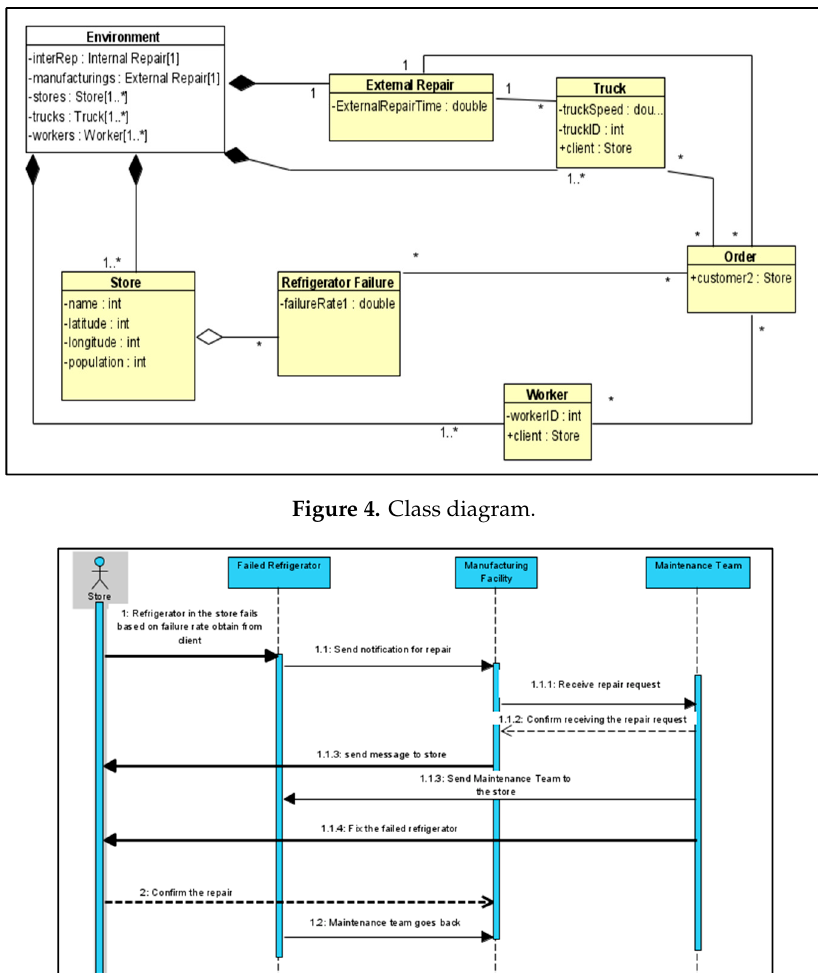
Figure 5. Sequence diagram.